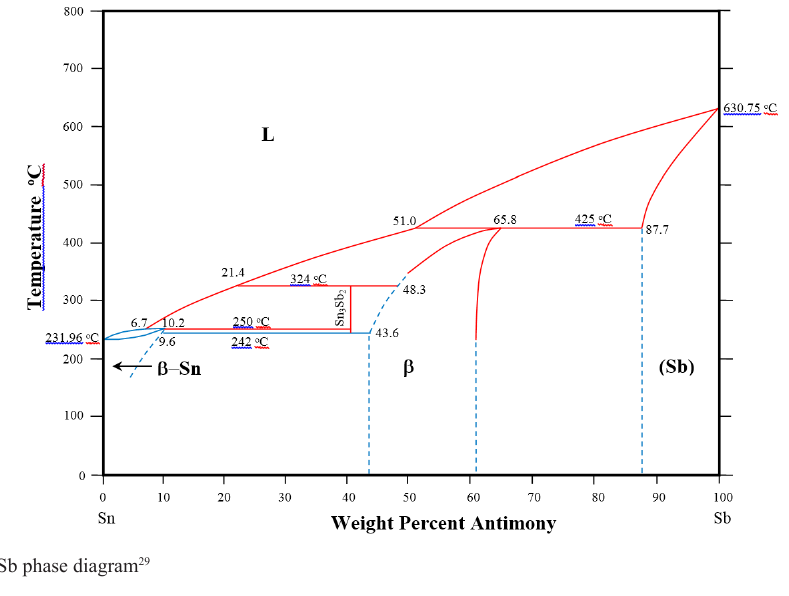
Figure 1. The Sn-Sb phase diagram 29